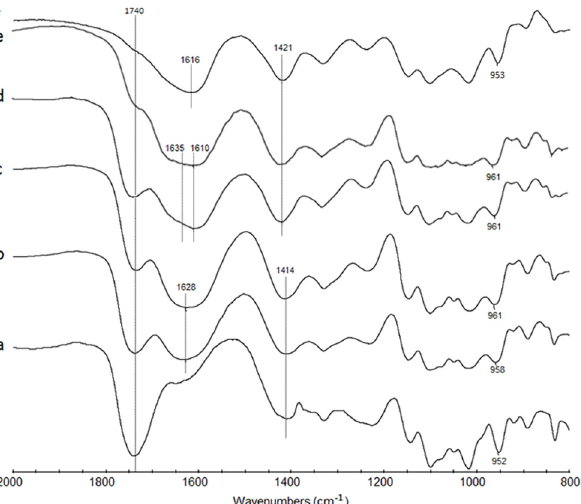
Fig 9. FT-IR spectra of HPGA (a), V(IV)-PGA systems at pH 3.0 (b), 4.0 (c), 5.0 (d) and 6.0 (e), and Na- PGA (f).